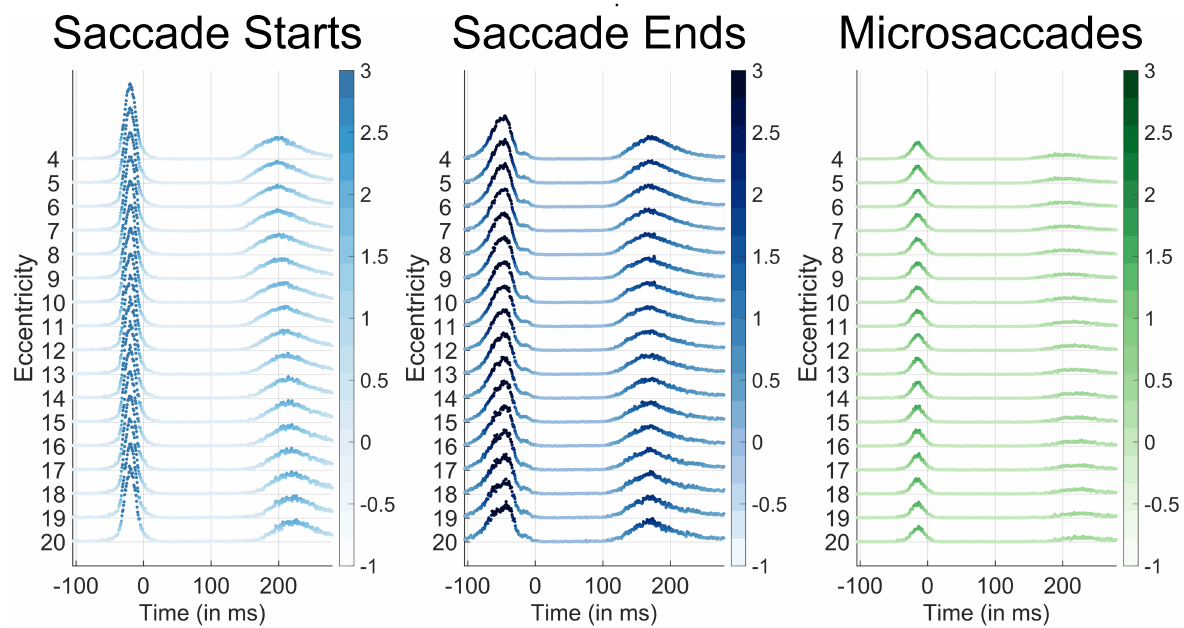
Figure 4. Saccade start (light blue), saccade end (blue), and microsaccade occurrence probabilities (green) per time bin according to the target eccentricity of the face target that appeared at 0ms. Time 0 corresponds to the new trial onset, which was immediately after the participant's gaze had reached the previous trial's face. Eccentricities are listed on the y-axis. The color and height of each data point represent the percent occurrence over all 96000 trials for saccade start times (left), saccade end times (center), and microsac- cade start times (right). The percent occurrence over 96000 trials is color coded according to the respective colorbars to the right of each plot. Note that microsaccades almost never occurred before the initial saccade after trial onset at any